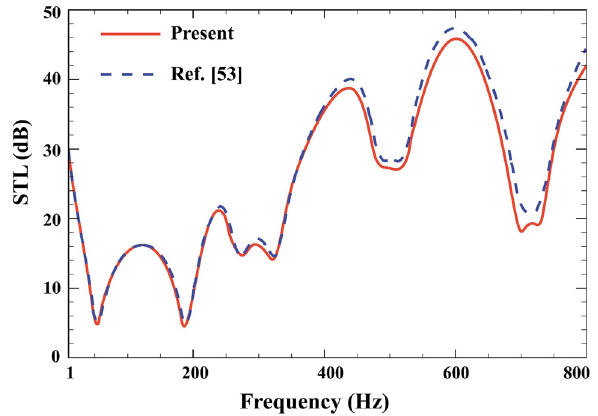
Figure 3. Comparison of STL through the double-walled elastic plate.